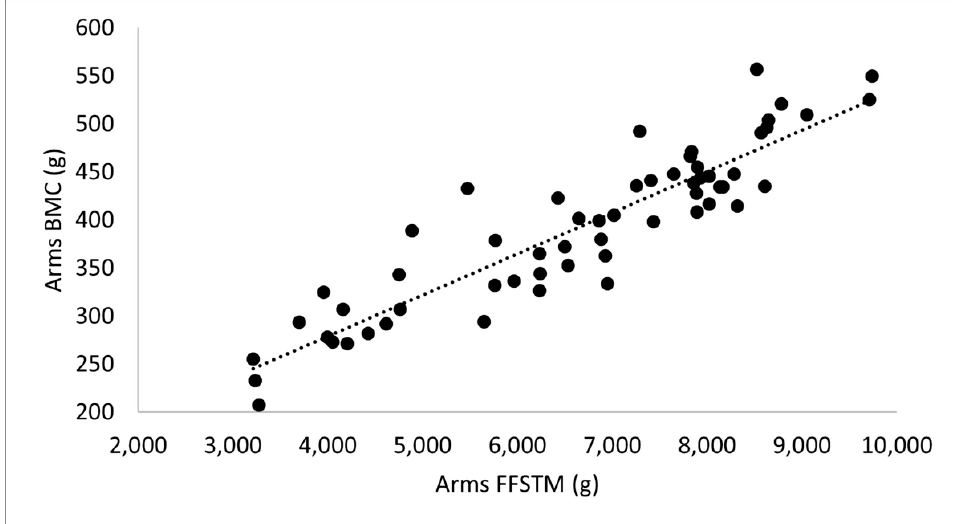
Figure 1. Relationship between fat-free soft tissue mass and bone mineral content in the arms assessed in 58 black belt karatekas competing at the national and international level. FFSTM, fat-free soft tissue mass; BMC, bone mineral content.